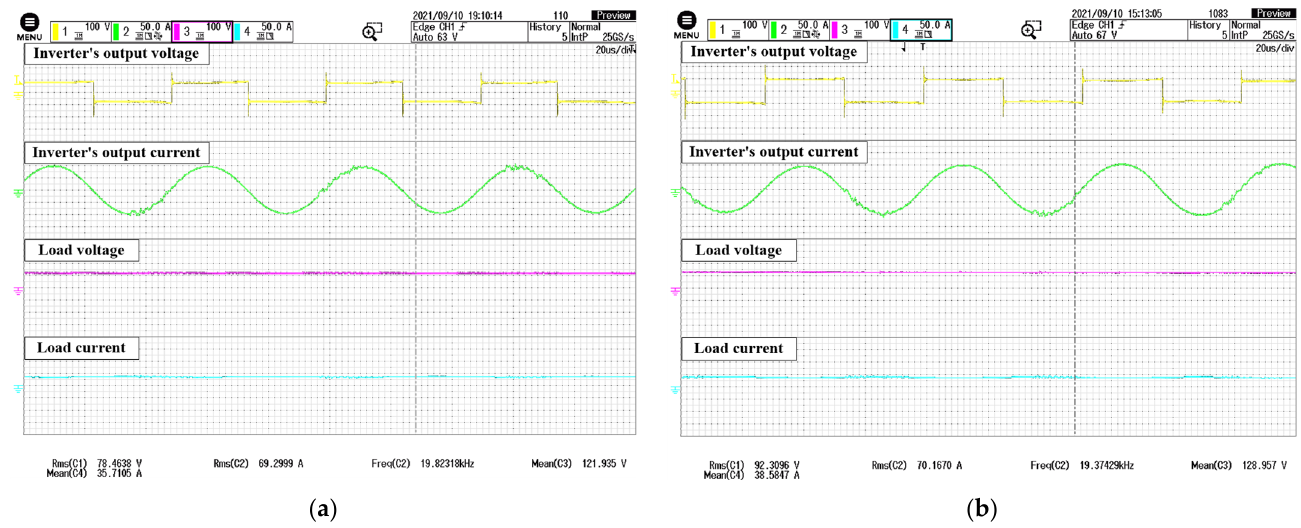
Figure 12. Power waveforms of the system with two receivers: ( a ) the dual-phase NSP receiver; ( b ) the dual-phase DD-OQO receiver. Table 3. Measured parameters of the magnetic coupler.